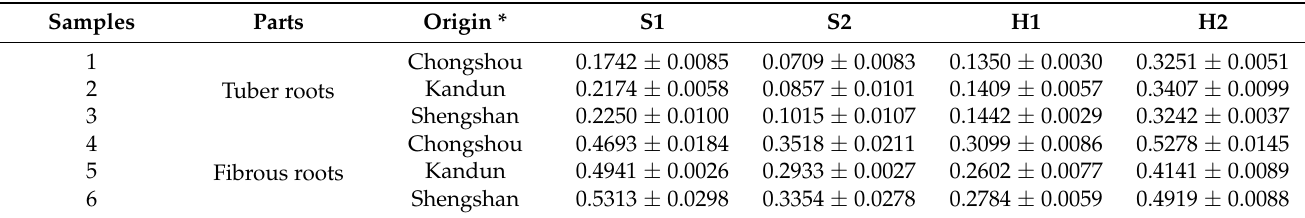
Figure 4. HPLC-DAD-ELSD chromatograms: mixed standard solution and typical ZOJ tuber sample on ELSD and DAD (296 nm): (S1) Cixi-ophiopogon B, (S2) Cixi-ophiopogon C, (H1) Methylophiopogonanone A, and (H2) Methylophiopogonanone B. Table 3. Analytical results of real samples of ZOJ (mg/g).